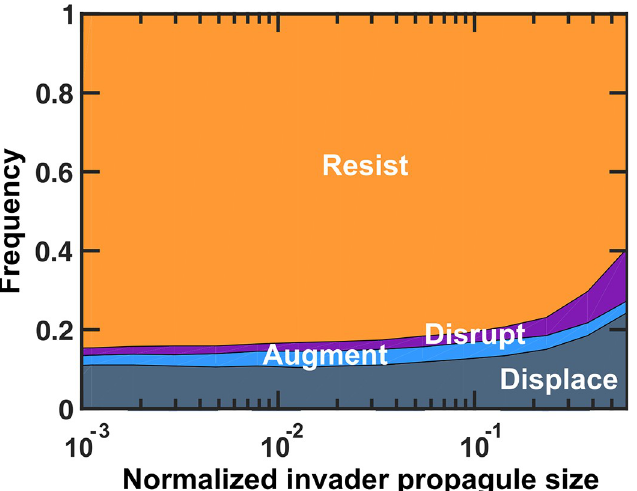
Fig 2. Only at large invader propagules colonization resistance is weakened. As the normalized propagule size ( i . e . the amount of invader cells introduced, relative to the total population size of the resident community) increases, the probability of resistance decreases, the probability of disruption and displacement increases, and the probability of augmentation remains approximately constant. Number of instances examined N s = 1000. Interactions among resident members are equally likely to be facilitative or inhibitory ( f fac = 0.5). Interactions between resident members and the invader are mostly inhibitory ( f = 0.1). The invader has on average a 50% advantage in basal growth rate fac , inv compared to resident members ( r / r = 1.5). To visualize the trends more clearly, here we do not include the 0 , inv 0 , res error-bars (see S1 Fig for confidence intervals).